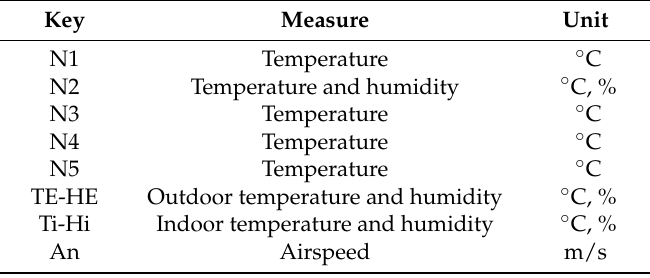
Table 3. The description of the sensors and measurement units. Key